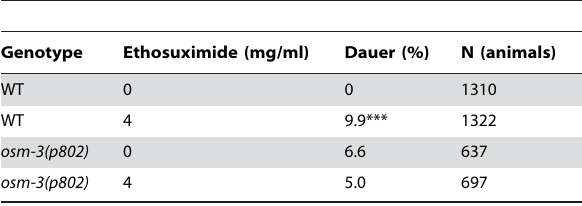
Table 4. Ethosuximide stimulated dauer formation in a low- density, well-fed population at 27 u